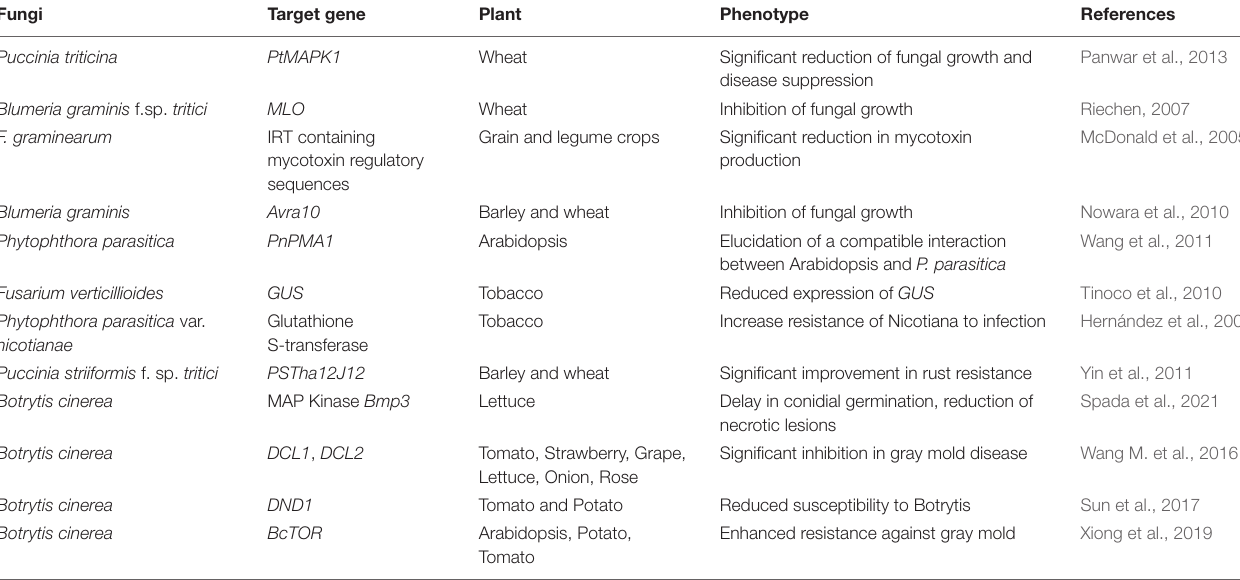
TABLE 2 | RNAi-targeted editing in plants against fungi.